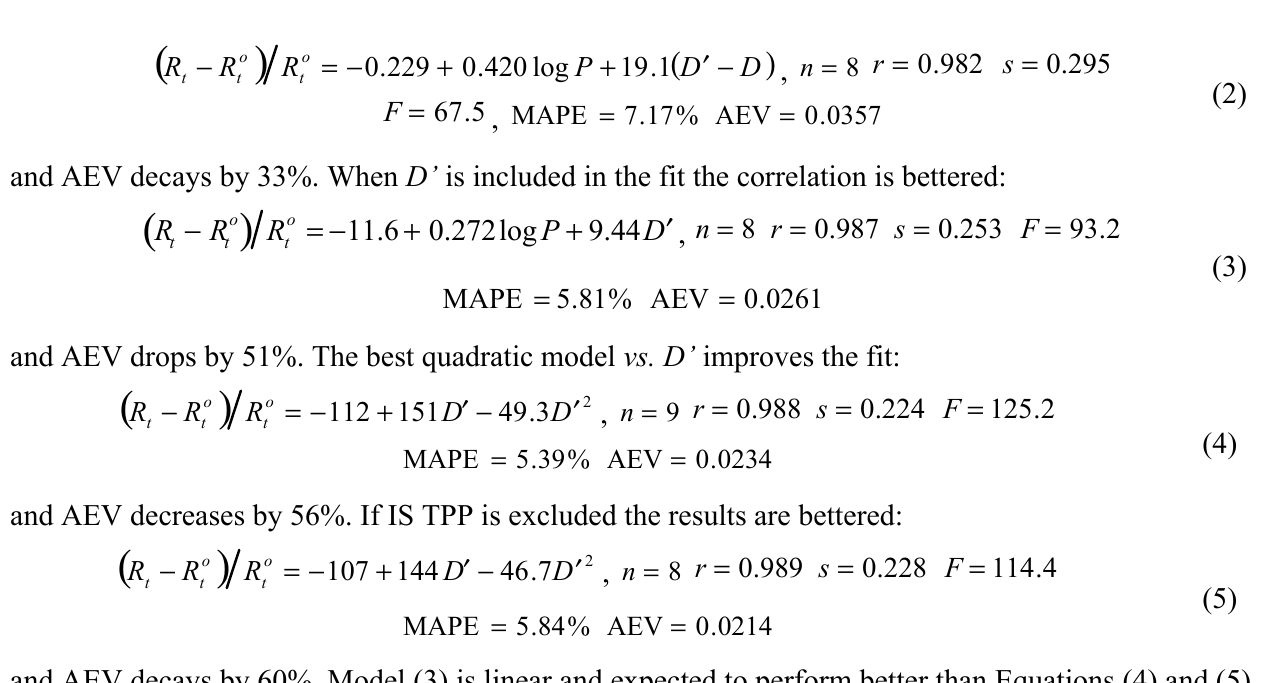
, O , NP, S=, N 123 0345